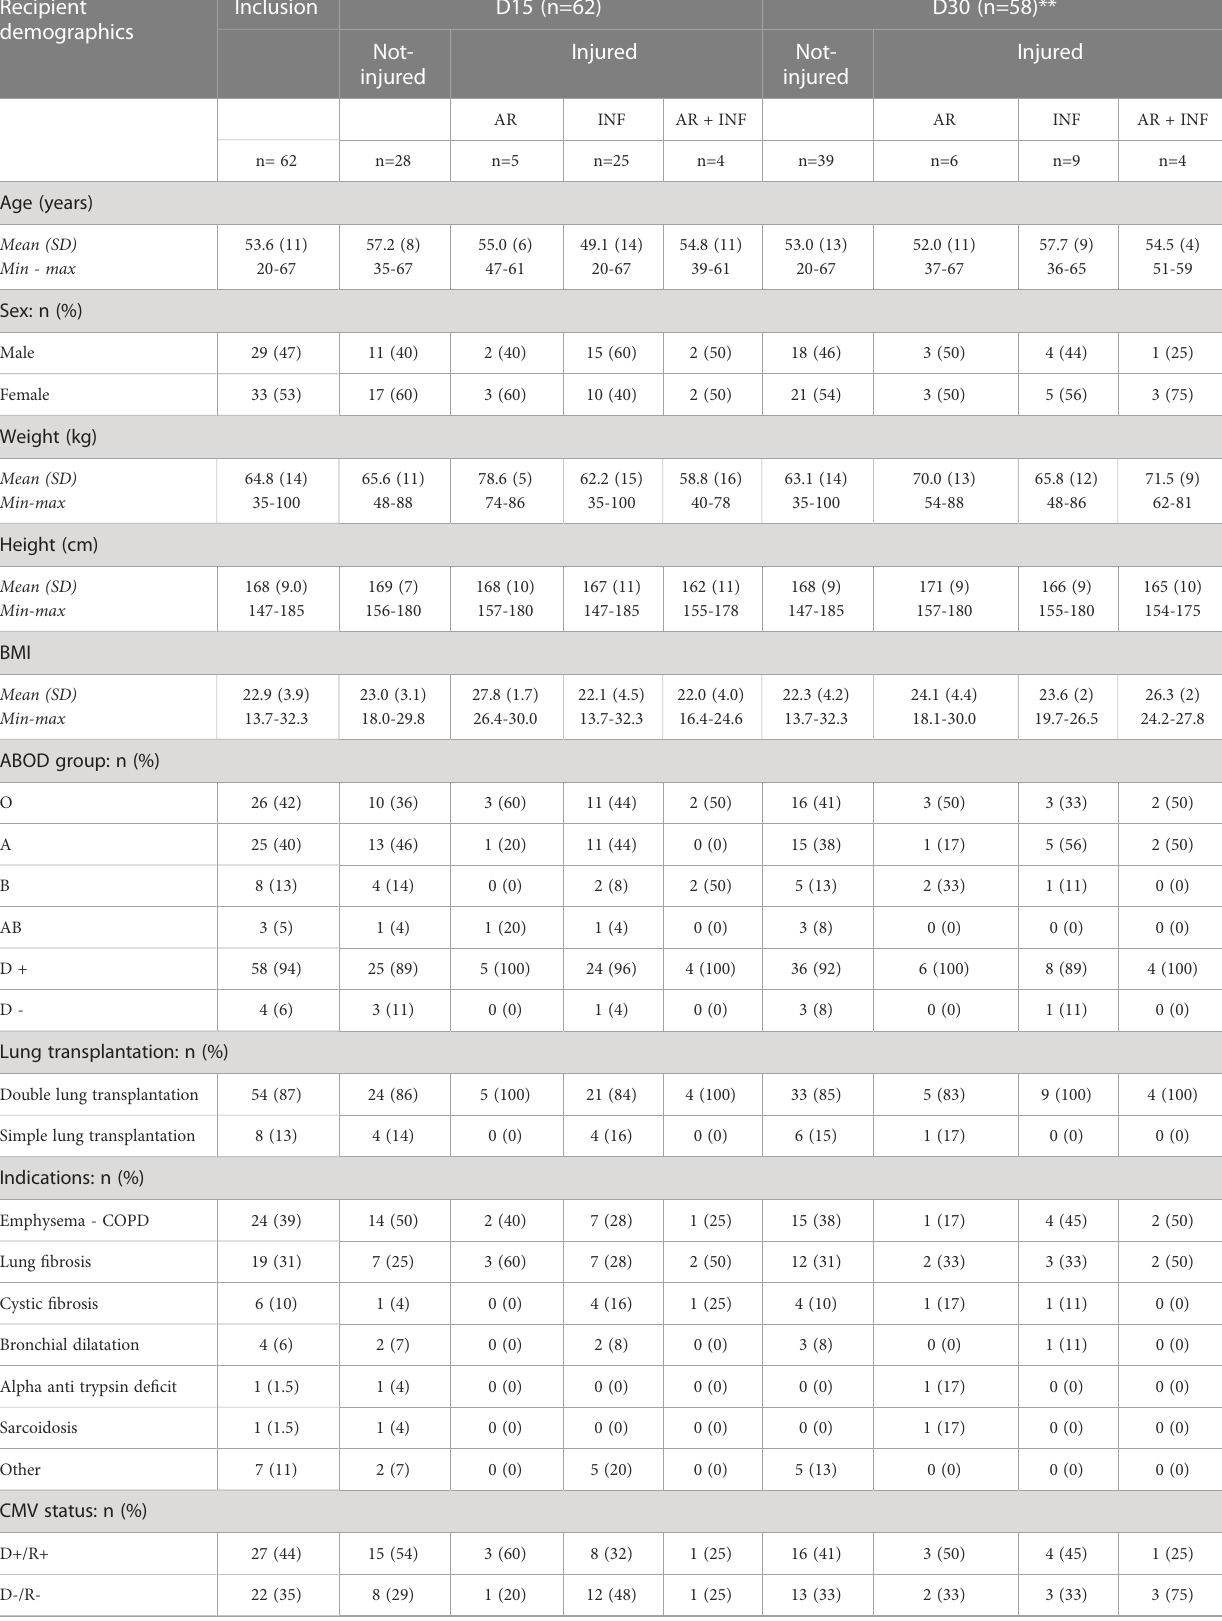
TABLE 1 patient ’ s characteristics at inclusion and at D15 and D30 according to their status. Recipient